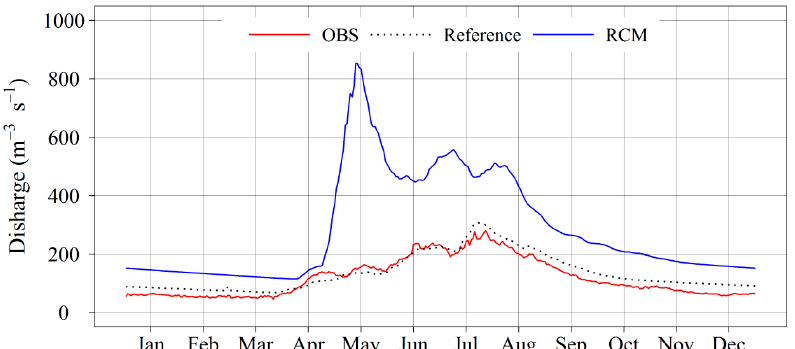
Figure 3. Average daily hydrographs for the observed discharges (OBS), simulated discharges using observed meteorological data (Reference), and simulated discharges using RCM data (RCM) at DSK stations during the reference period 1986–2004.